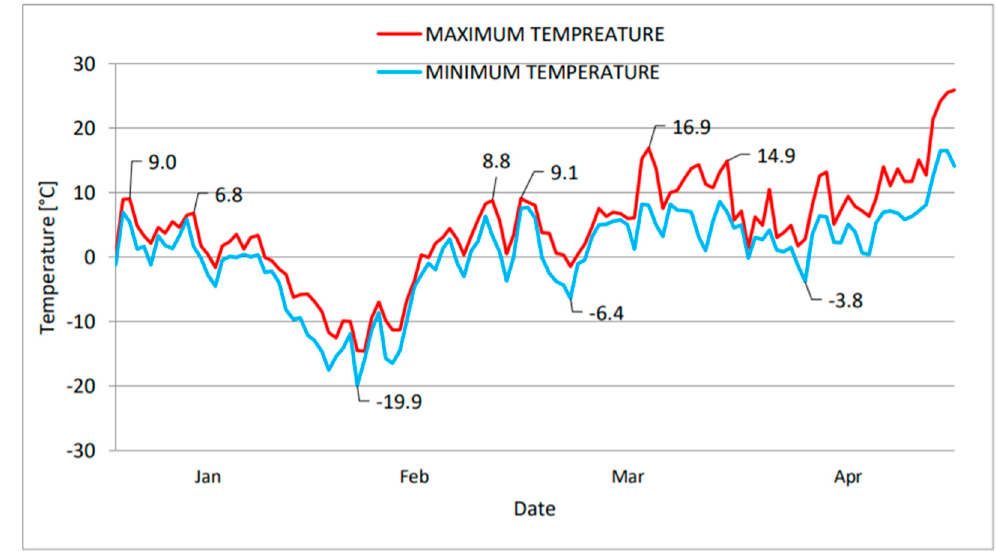
Figure 2. Minimum and maximum temperatures from January to April 2012.